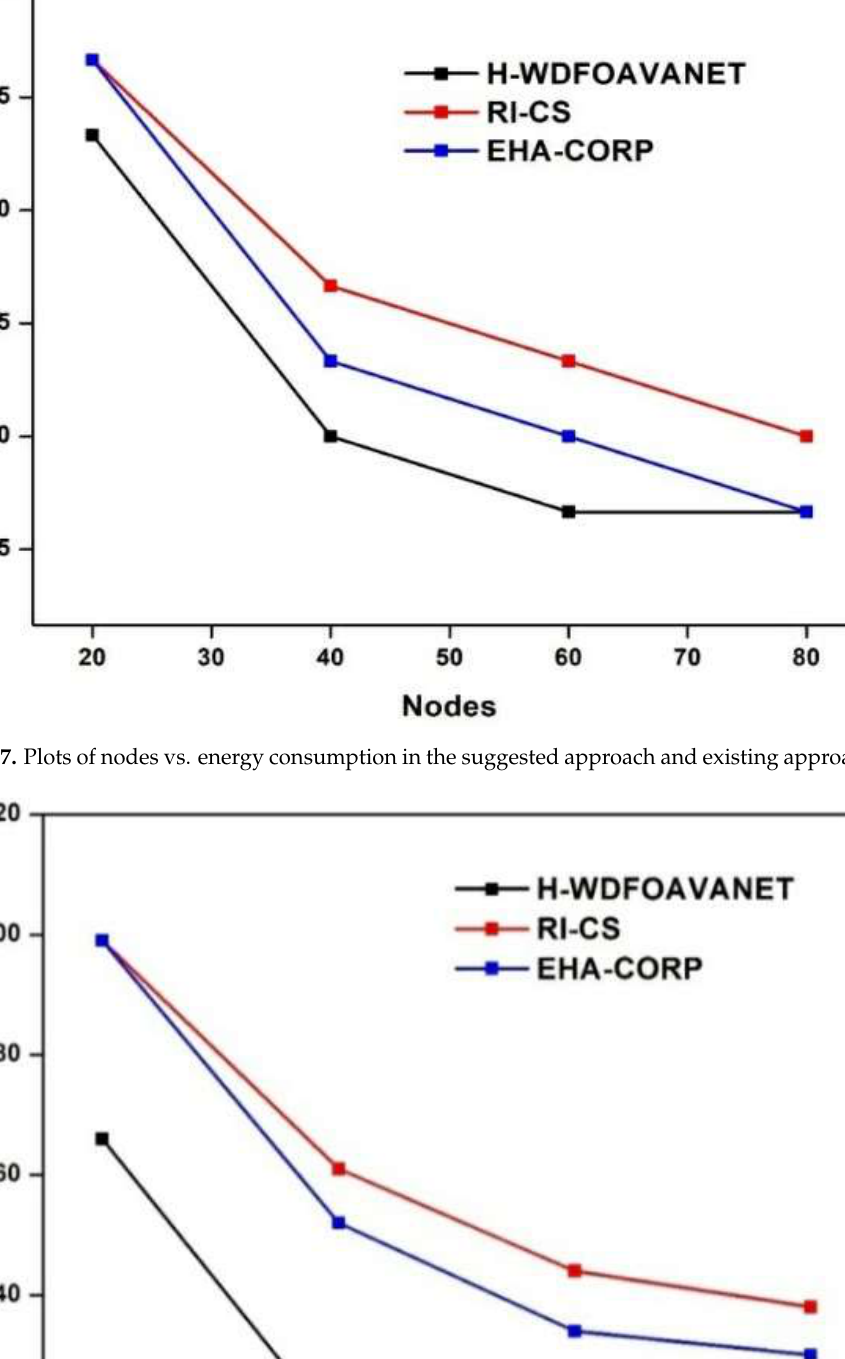
Figure 16. Plots of nodes vs. drop in the suggested approach and existing approaches.